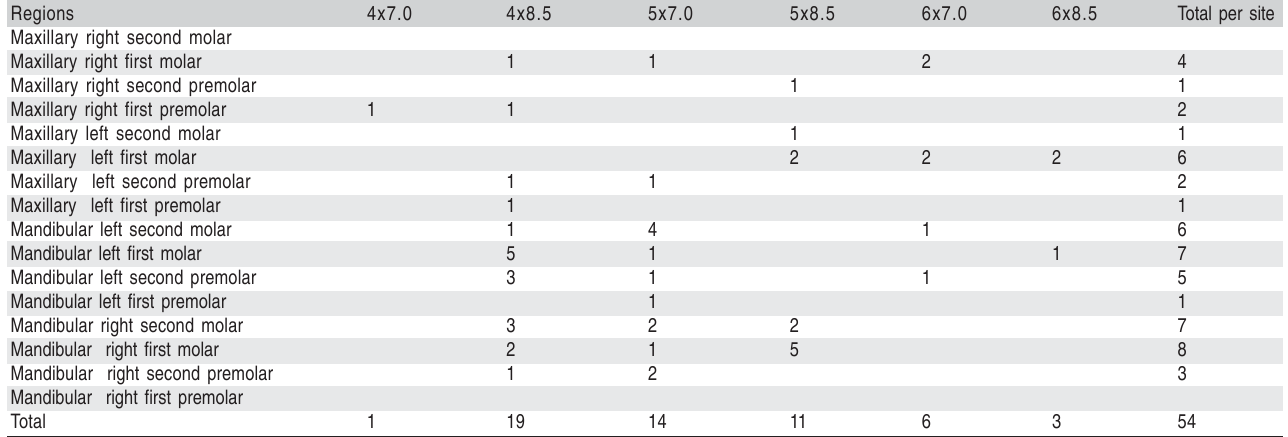
Table 2. Characteristics of implants used in different areas of the dental arches (width x length).